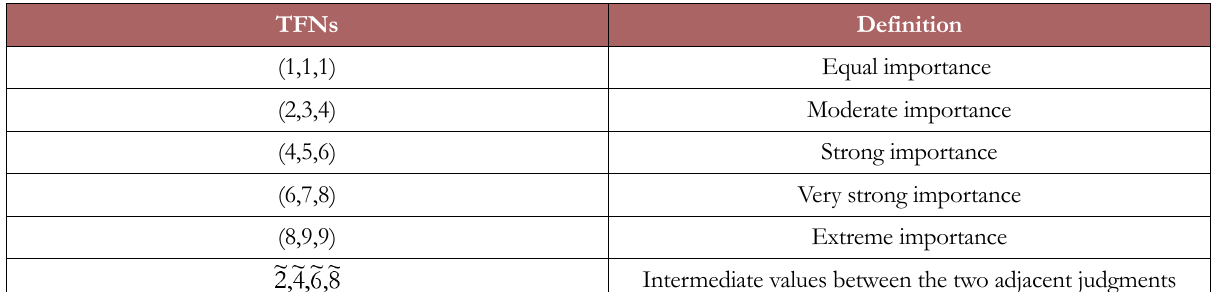
Table 1. The 9 - point scale of